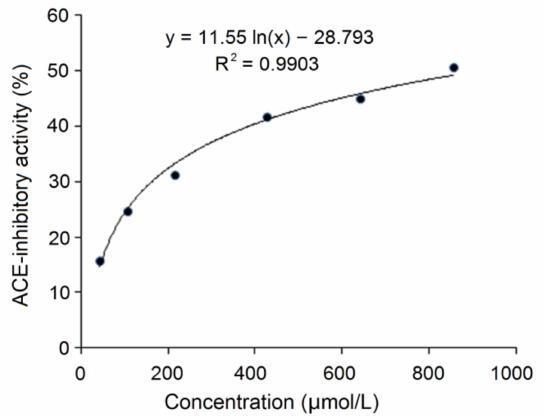
Figure 4. The regression analysis on ACE-inhibitory activity of